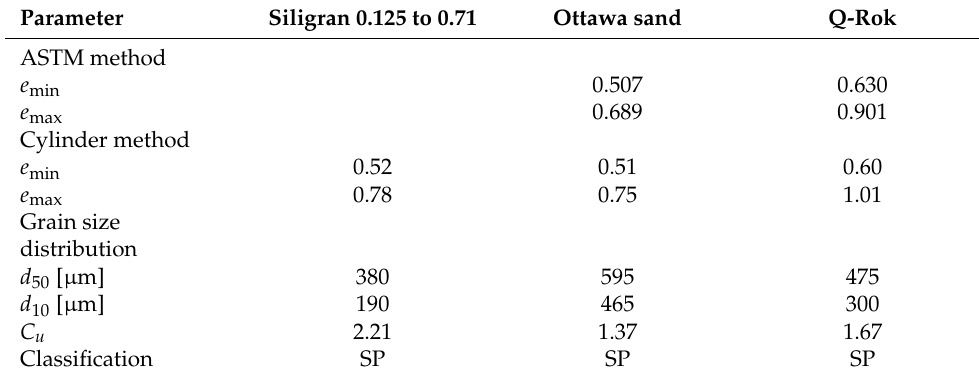
Table 1. Void ratio, and some index properties for Siligran 0.125–0.71, Ottawa sand, and